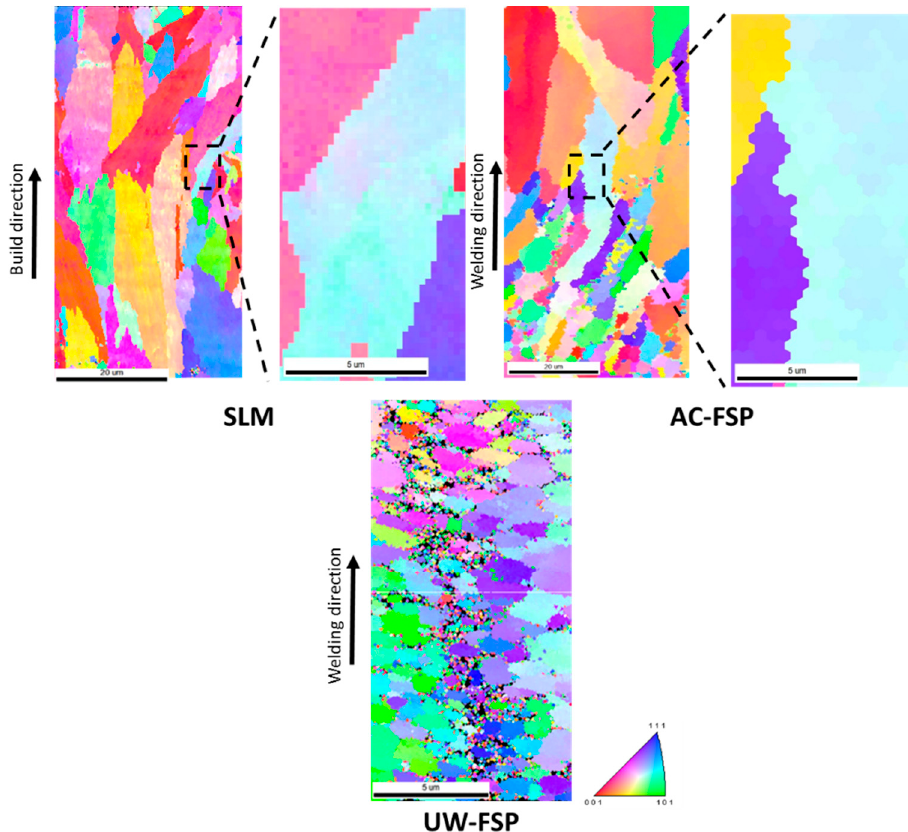
Figure 2. EBSD micrographs of SLM, AC-FSP and UW-FSP samples; color coding is in line with the standard triangle shown to the lower right.